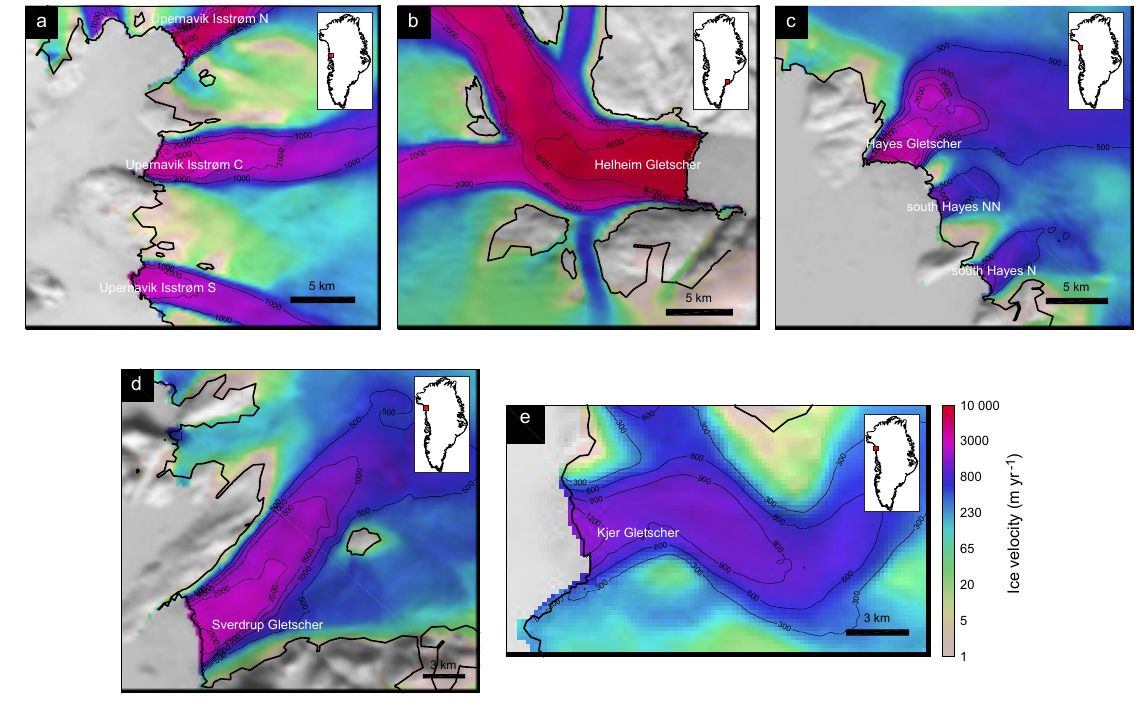
Figure 1. Ice surface velocity (black contours) for study glaciers (a) Upernavik Isstrøm, (b) Hayes, (c) Helheim, (d) Sverdrup, (e) Kjer. The thick black line is the ice